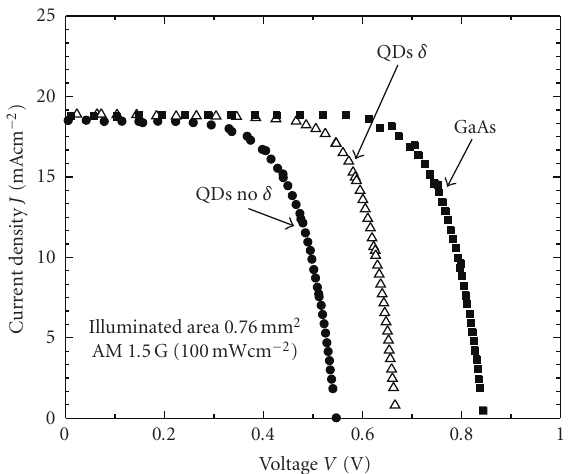
Figure 13: The light current density-voltage characteristics of GaAs reference cell, GaAs IBSC solar cells based on quantum dot with and without delta ( δ ) doping of quantum dot layers (from